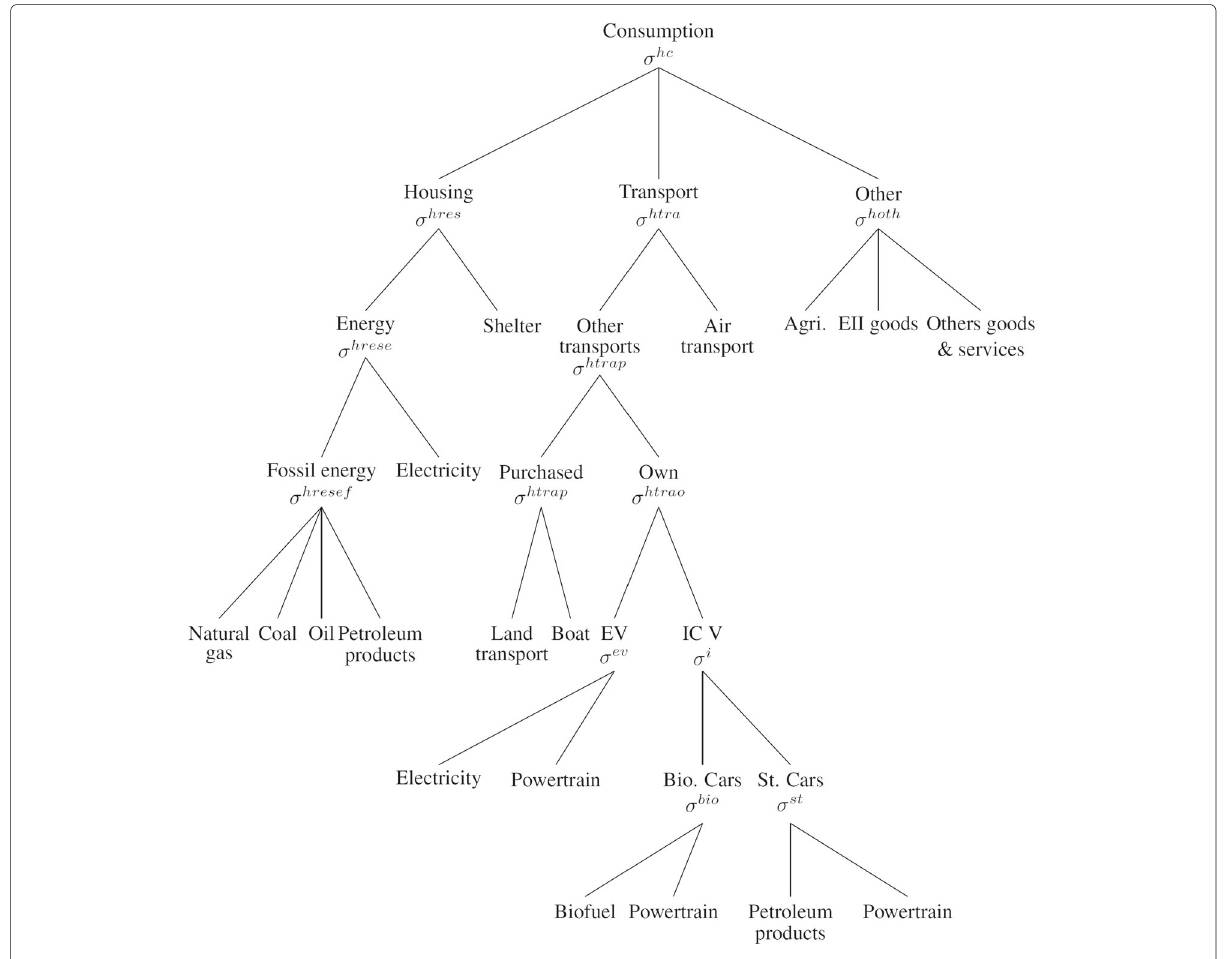
Fig. 1 Nested CES structure of household consumption